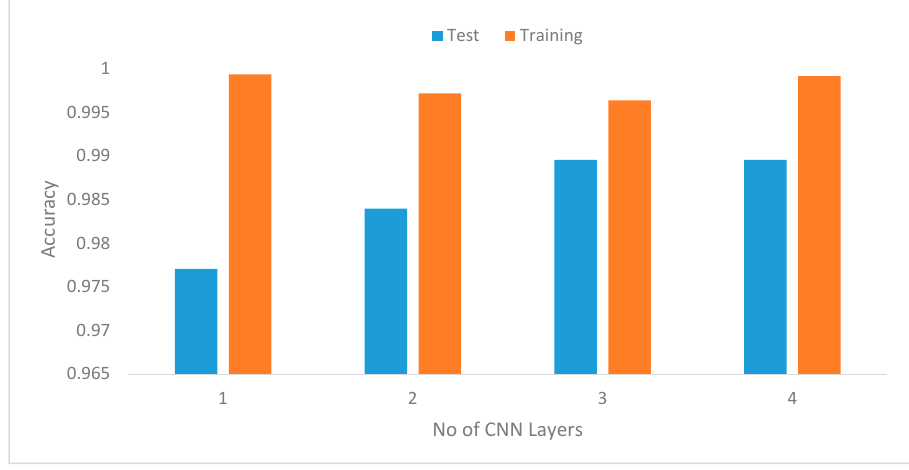
Figure 20. Model recognition accuracy with increasing number of CNN layers.